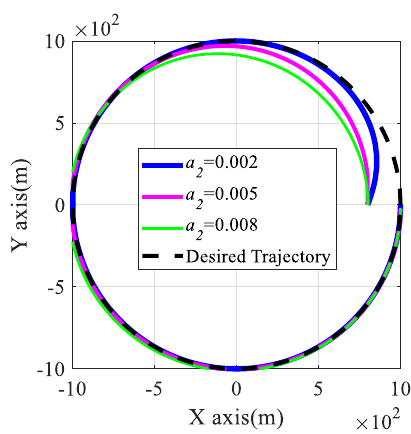
Figure 11. Tracking histories of controlled AUSV with respect to different control gains a 2 .